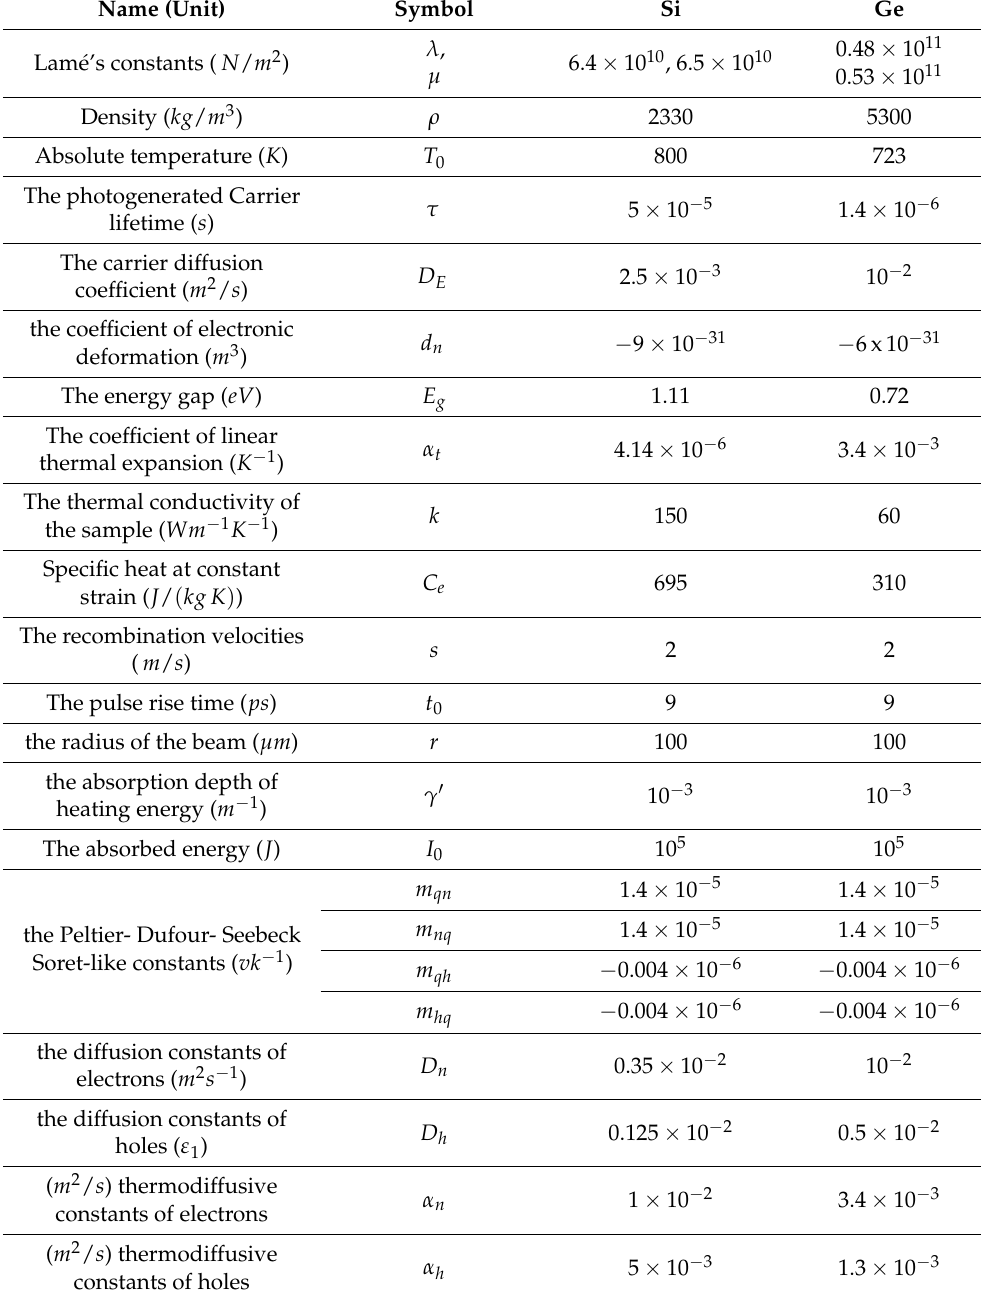
Table 1. Physical constants of Si and Ge